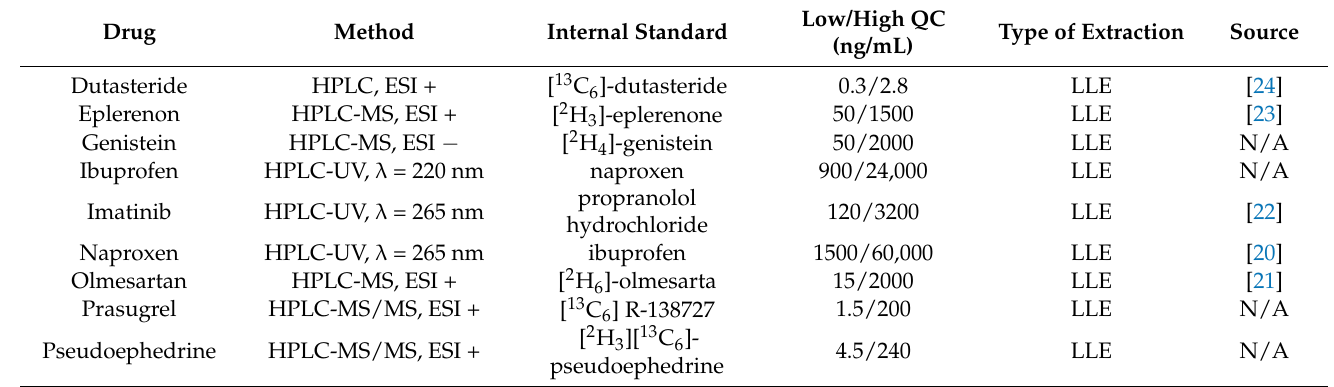
Table A3. Characteristics of the bioanalytical methods for the determination of the nine drugs used for retrospective